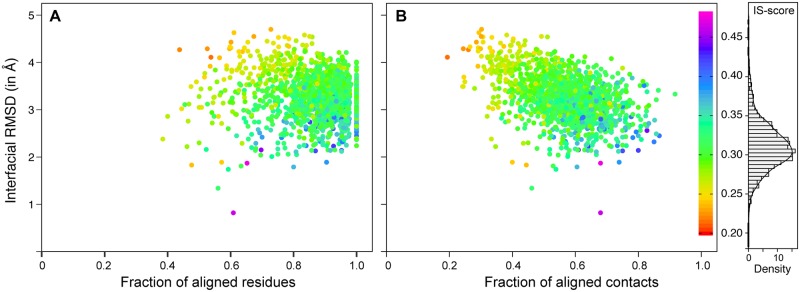
Structural comparison of inter-chain domain and intra-chain domain interfaces.Scatter plot of interfacial RMSD versus (A) fraction of aligned residues (fres) and (B) fraction of aligned contacts (fcon) for the closest match of 1464 protein-protein interfaces with intra-chain domain interfaces. Distribution of IS-score is shown as histogram.